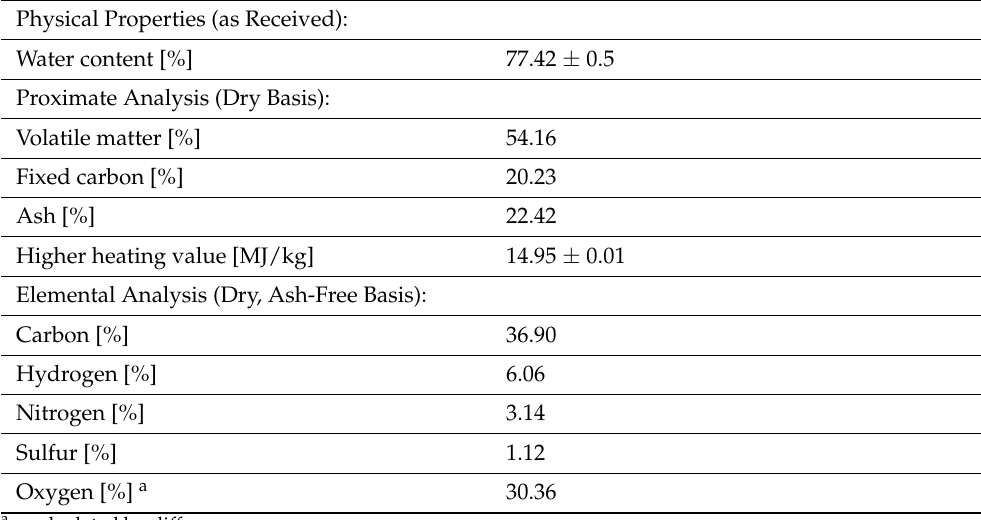
Table 4. Compositional analysis of freshly harvested winter F. vesiculosus